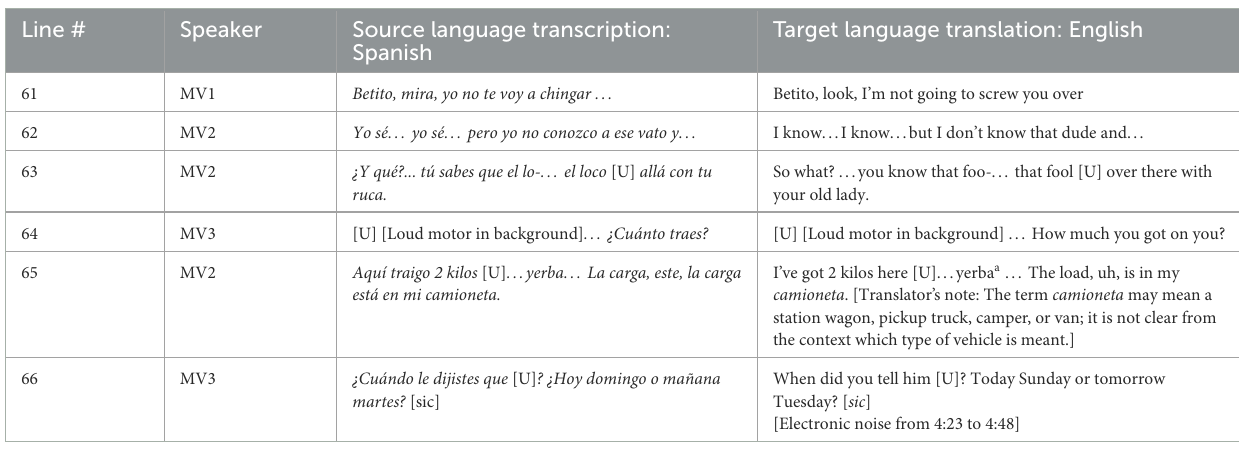
TABLE 2 Recommended FTT